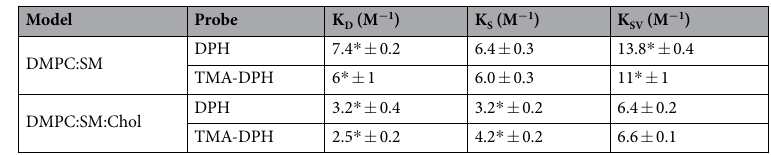
Table 2. Fluorescence quenching parameters (K D , dynamic constant; K S , static constant; K SV , Stern–Volmer constant) determined from the quenching of DPH and TMA-DPH by doxorubicin in the different mimetic models at pH 7.4 and 37 °C a . a All values represent the mean ± standard deviation (n = 3). * p < 0.05 statistically different from the other probe, for each fluorescence quenching